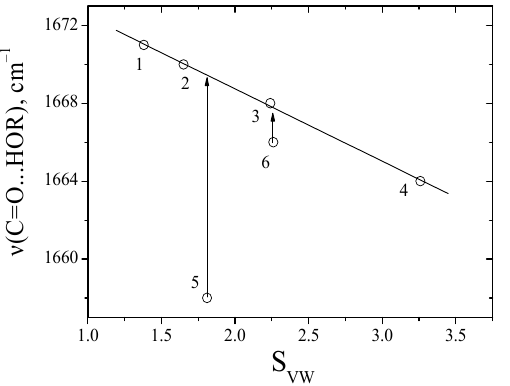
Figure 6. Comparison of the absorption frequencies of the C=O group of the between complex Figure 6. C о mparison of the absorption frequencies of the C=O group of the between complex sarcosine anhydride with m е thanol in solvents and S VW , values correspond to the data in Table 2. sarcosine anhydride with methanol in solvents and S VW , values correspond to the data in Table 2. Table 4. The parameters A b of alanine (AA) and sarcosine (SA) anhydride with methanol in the media chloroform and